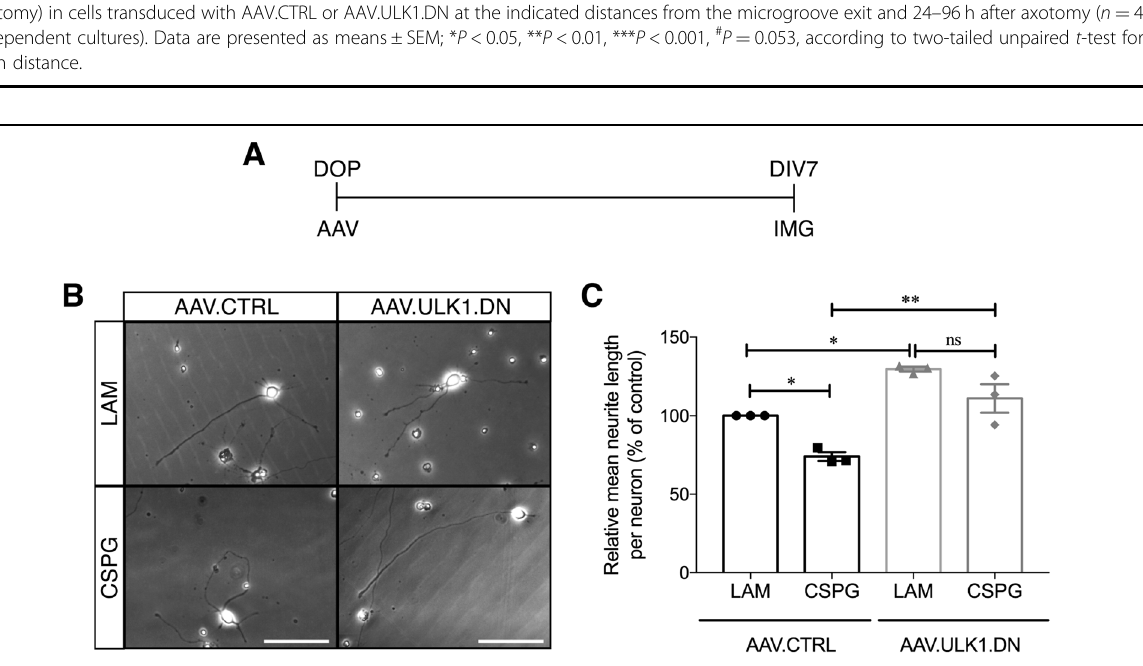
DN or AAV.CTRL were grown on the permissive sub- strate laminin as well as the growth-inhibiting matrix CSPG, which is produced by glial cells after CNS lesion 19 .